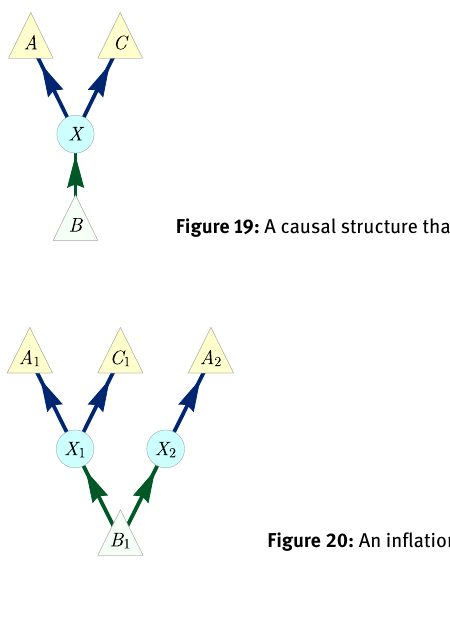
Figure 19: A causal structure that is compatible with any distribution P ABC .